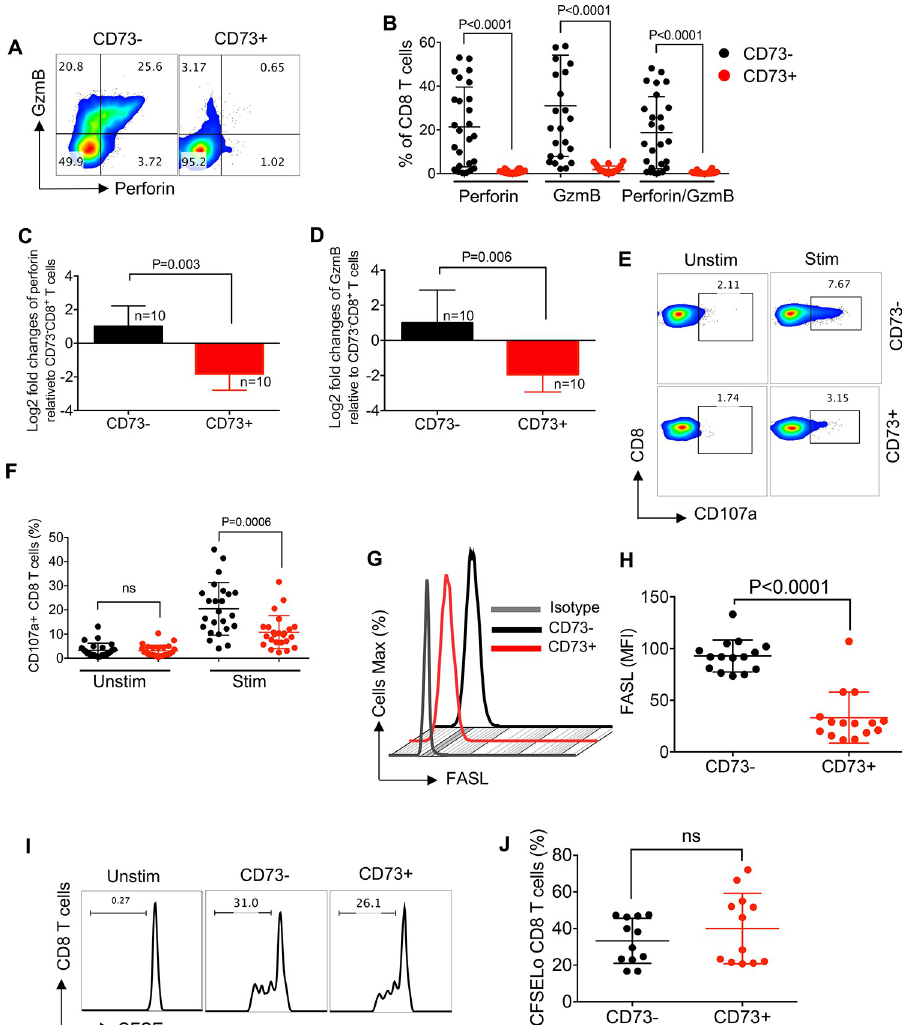
Fig 4. Impaired expression of cytolytic molecules in CD73 + CD8 + T cells. ( A ) Representative flow cytometry plots, and ( B ) cumulative data showing the expression of perforin, GzmB and perforin/GzmB in CD73 + versus CD73 - CD8 + T cells. ( C ) Fold regulation of perforin gene, and ( D ) GzmB gene in CD73 + relative to CD73 - CD8 + T cells in HIV- infected individuals quantified by qPCR. ( E ) Representative flow cytometry plots of CD107a, and ( F ) cumulative data of CD107a in CD73 - versus CD73 + CD8 + T cells pre- and post-stimulation with anti-CD3/CD28 antibodies. ( G ) Representative histogram plots, and ( H ) cumulative data of FASL expression as measured by the mean fluorescence intensity (MFI) in CD73 - versus CD73 + CD8 + T cells on HIV-infected individuals. ( I ) Representative flow cytometry plots, and ( J ) cumulative data of CD73 + versus CD73 - CD8 + T cells proliferation measured by CFSE after 3 days of stimulation with anti-CD3/CD28 antibodies. Each point represents one HIV-infected individual. Data are obtained from multiple independent experiments. Each dot represents data from an individual human subject. Statistical analysis determined by the Mann-Whitney U-test (B, C, D, F, H and J) with significance indicated. ns: no significant. n: reflects the number of samples. CD73 + versus CD73 - CD8 + T cells in vitro (Fig 5E). We further confirmed this concept by mea- suring the expression of CD73 in CD8 + T cells in the gut tissue versus the peripheral blood in mice. As shown in Fig 5F and 5G, we found a significant abundance of CD73 + CD8 + T cells in the gut tissues compared to the peripheral blood in mice. These results may support the con- cept of a higher capacity of CD73 + CD8 + T cells to migrate to lymph nodes and gut-associated